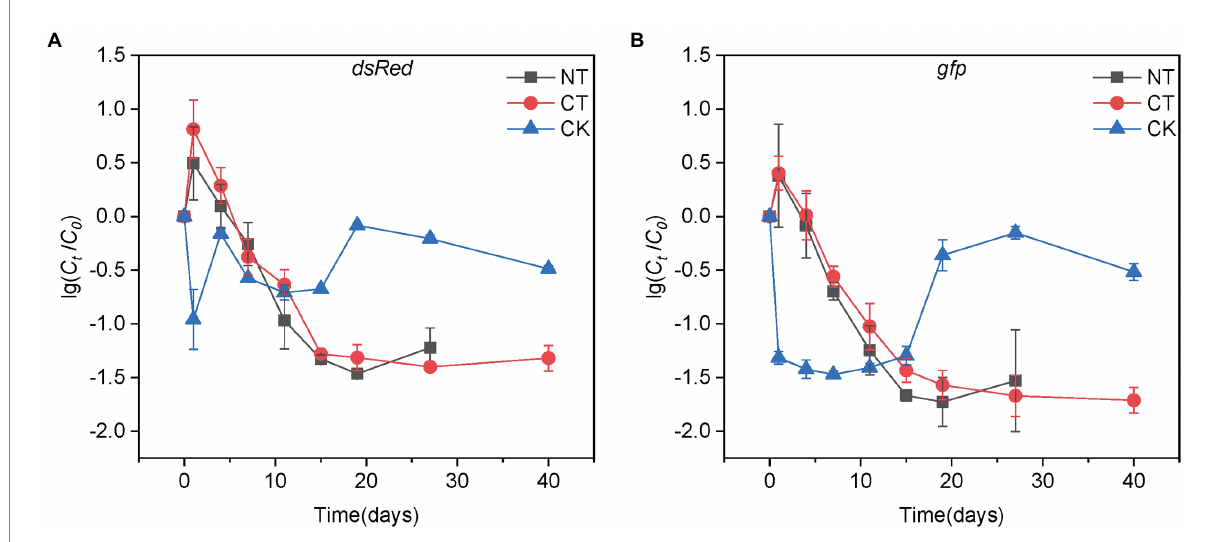
FIGURE 1 The decay of the donor (A) and plasmid (B) during normal thermophilic (NT) and continuous thermophilic composting (CT). The log values of the ratios of donor (plasmid) concentration at time t ( C t ) to the initial concentration ( C 0 ) are shown on the y-axis. The donor and plasmid concentrations are represented by the copy numbers of dsRed and gfp genes, respectively. Error bars represent the standard deviation (SD) of sampling replicates at each time